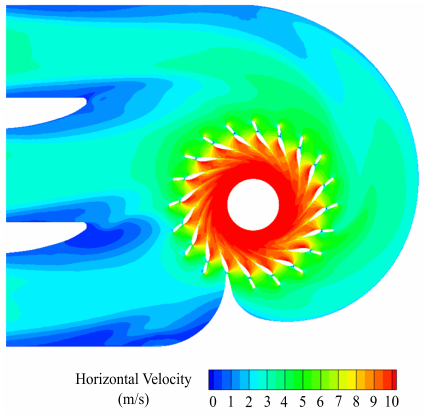
Figure 1. Computational model of Ice Harbor Dam [23] showing representative horizontal flow velocity in the intake and distributor. The horizontal direction is defined as being perpendicular to runner axis.